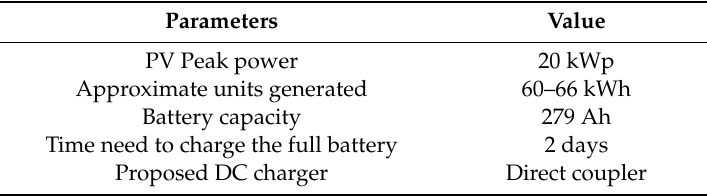
Figure 2. Scheme of the proposed system. Table 1. Main parameters for the service vehicle.